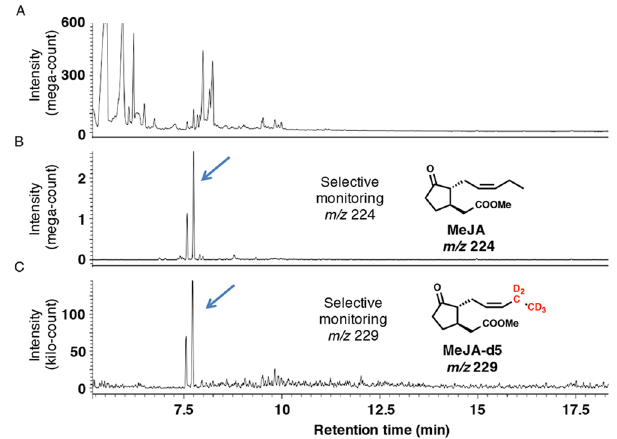
Figure 4. Representative GC-MS chromatograms for measuring MeJA in feeding experimet using LA-d5. ( A ) Representative GC-MS chromatogram monitoring total ion. ( B ) Representative GC-MS chromatogram for measuring fungal derived MeJA using selected ion monitoring at m / z 224. ( C ) Representative GC-MS chromatogram for measuring fungal derived MeJA-d5 using selected ion monitoring at m / z 229. Representative MS chart of the peak indicated by arrow is given in Supplementary Figure S4.